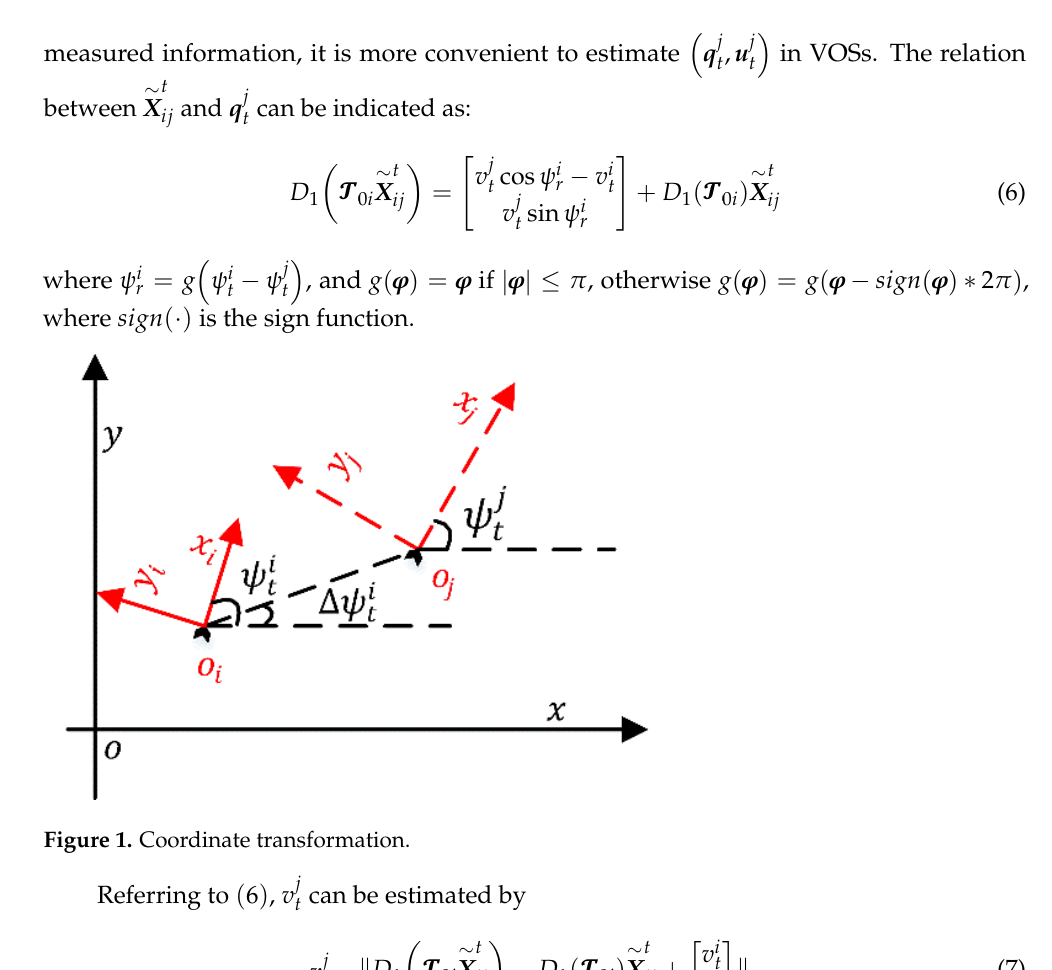
Figure 1. Coordinate transformation.